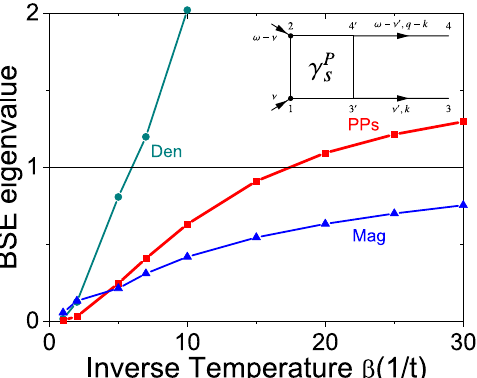
Fig. 4 Leading instabilities. The maximum eigenvalues of the Bethe-Salpeter equation (BSE) for the particle-particle singlet (PPs), density (Den) and magnetic (Mag) channel for doped plaquette with U = 5.56 and t 0 = − 0.15t, μ = 1.55. Insert: diagrammatic representa- tion for BSE-matrix in the particle-particle channel.